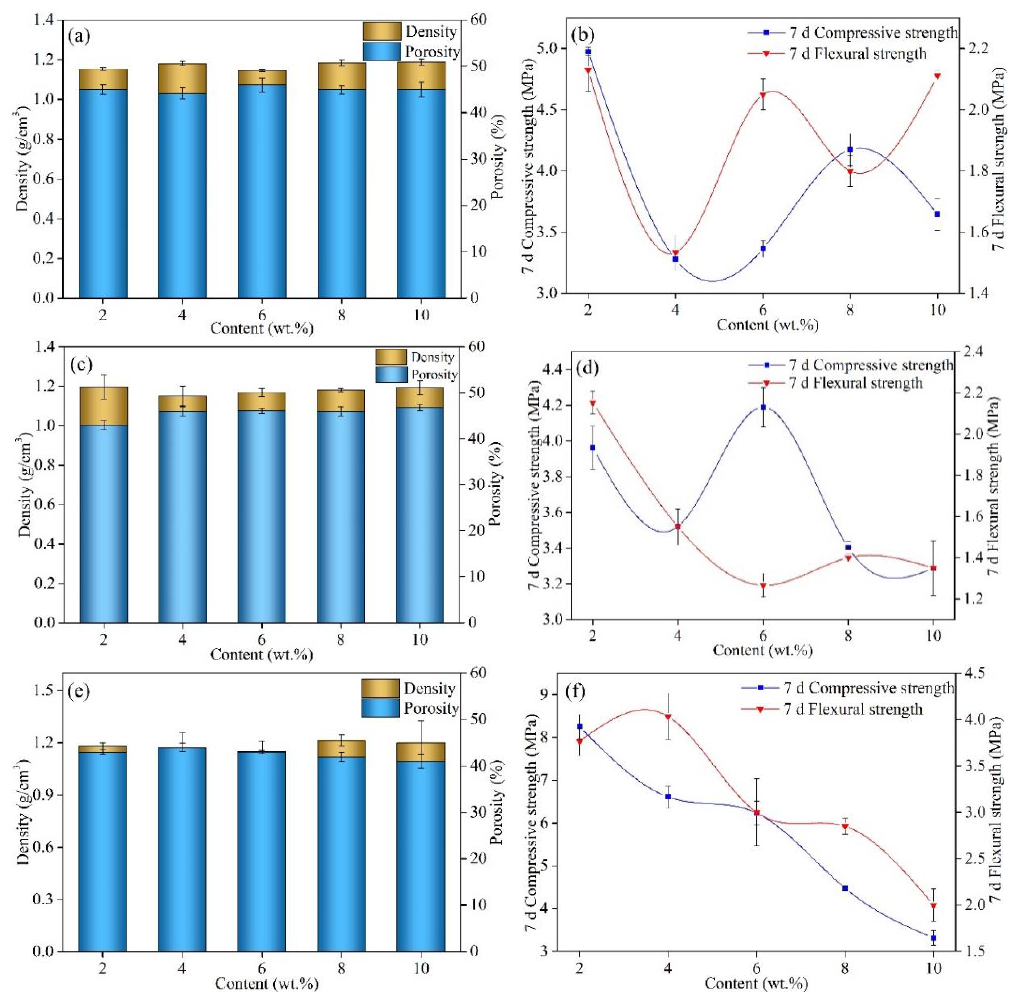
Figure 2. Densities, porosities, 7 d compressive strengths, and 7 d flexural strengths of PA/gypsum composites mixed with ( a , b ) iron powder, ( c , d ) copper powder, and ( e , f )